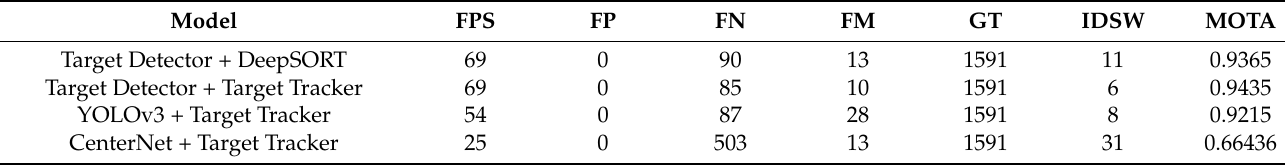
Table 4. Comparison of model performance before and after